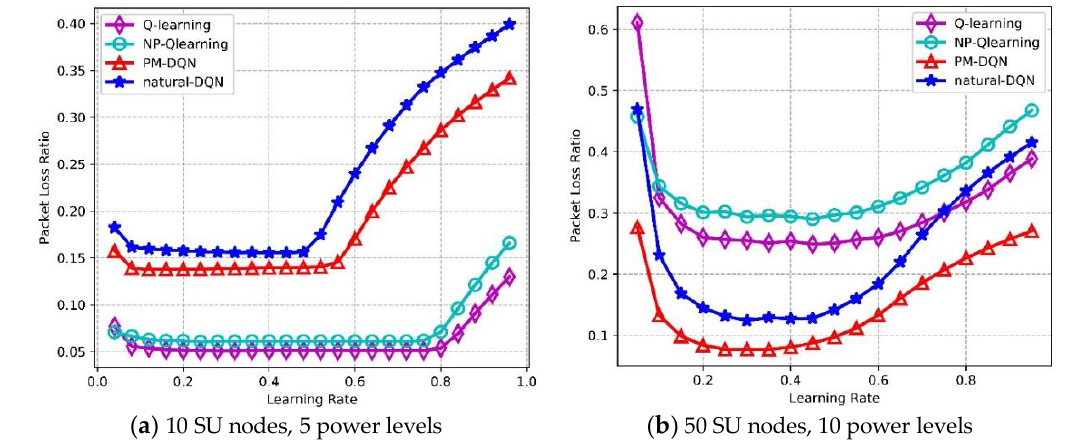
Figure 15. Packet loss ratio vs. learning rate.